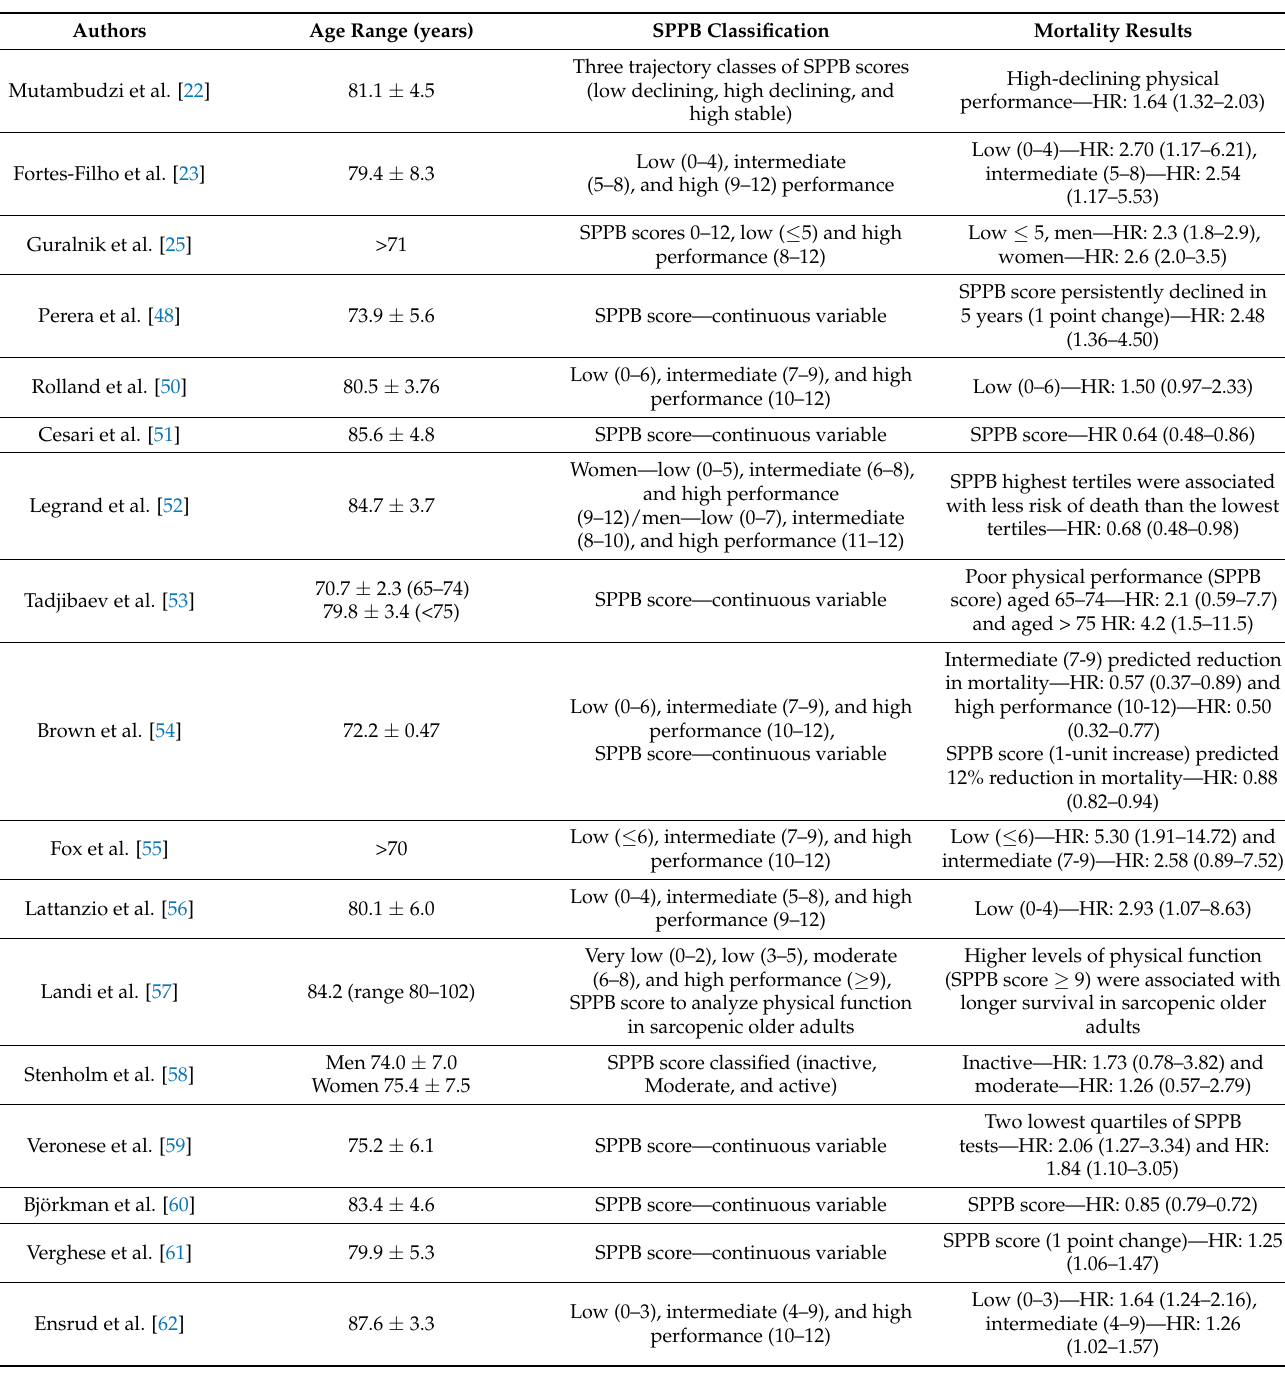
Table 2. Characteristics of longitudinal studies according to the SPPB classification and mortality outcome ( n =